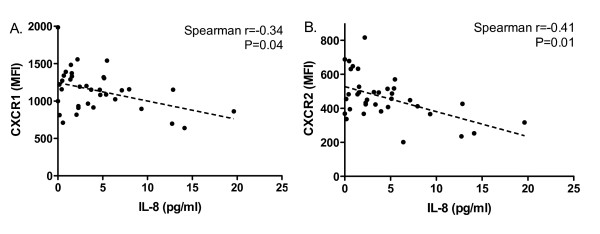
CXCR1/CXCR2 expression correlates with IL-8 levels in quiescent AAV. Expression of CXCR1, CXCR2 and levels of IL-8 were measured in parallel in patients in remission (n = 37). Membrane expression of CXCR1 and CXCR2 is presented as MFI corrected for nonspecific binding of isotype control antibodies on neutrophils. IL-8 levels are presented as concentration in serum. A. Correlation between CXCR1 expression on neutrophils and serum levels of IL-8 (Spearman r = -0.34, P = 0.04). B. Correlation between CXCR2 expression on neutrophils and serum levels of IL-8 (Spearman r = -0.41, P = 0.01). Dotted lines represent the best-fit correlation between expression of CXCR1/2 and IL-8 levels. AAV, ANCA-associated vasculitides; ANCA, anti-neutrophil cytoplasmic autoantibody; IL, interleukin.